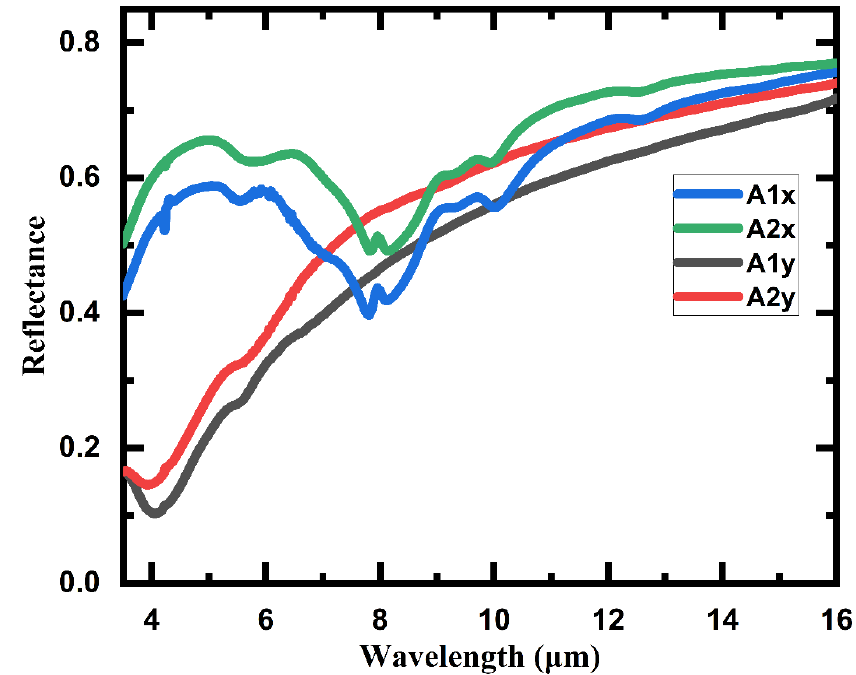
Figure 9. Measured IR reflection spectra of the 3D meta-atom arrays under normal incidence, with the polarization along the X-axis (A1x, A2x) and Y-axis (A1y, A2y). The tested samples are Array1 (A1x, A1y) and Array2 (A2x, A2y).